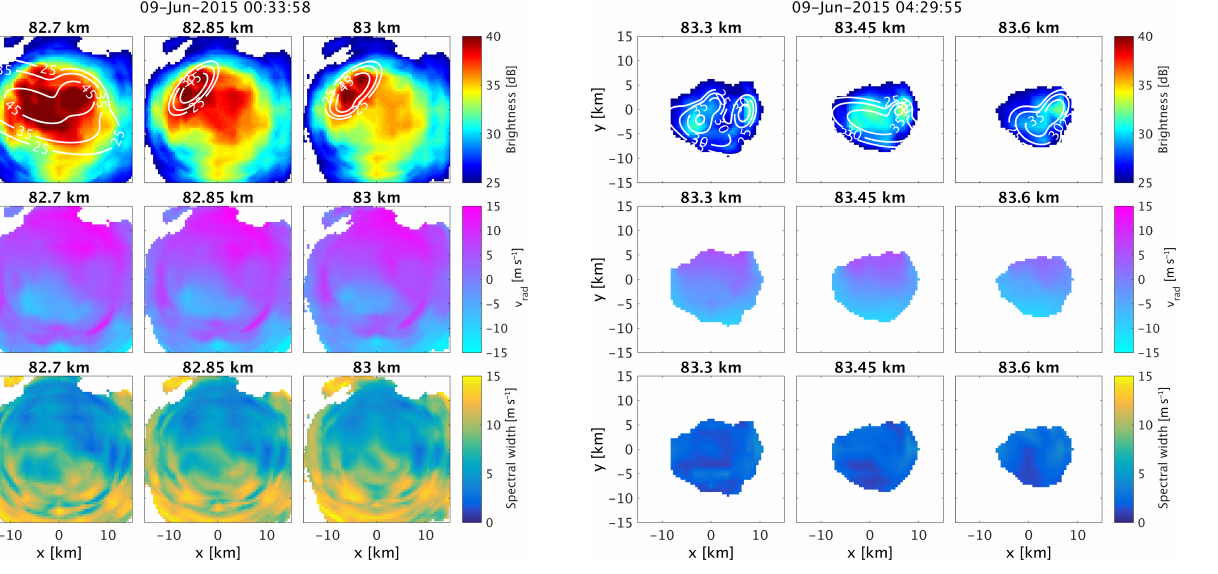
Figure 4. Spectral parameters of PMSE after converting the image to Cartesian coordinates and altitude on 9 June 2015 00:33:58UTC. The columns show three adjunct altitudes around the strongest PMSE altitude of 82.85km. The brightness distributions are shown in the top row and are colour coded. The white lines indicate the fit- ted Gaussian ellipsoids. The middle row shows the radial velocities, indicating a horizontal wind, and the bottom row shows the imaged spectral width.